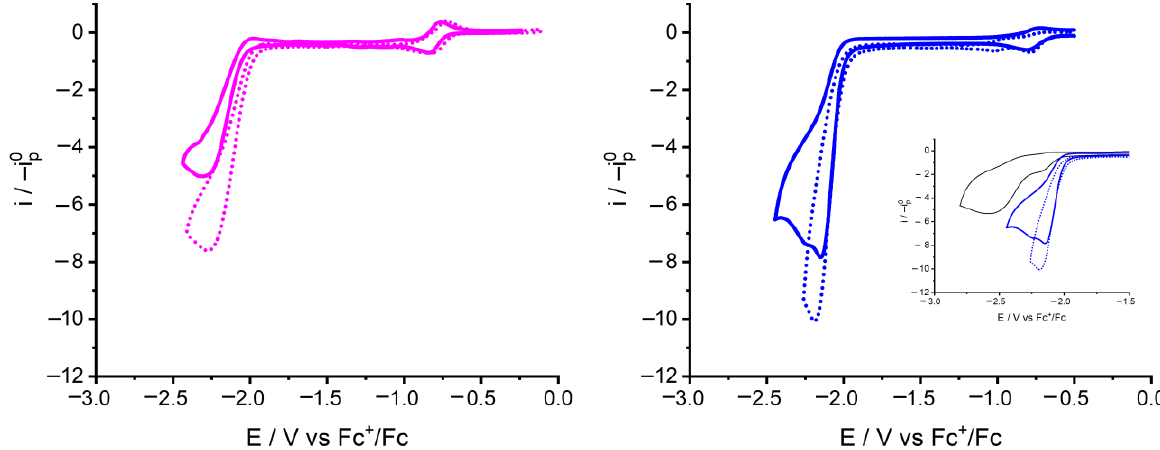
Figure 5. Cyclic voltammetries of 1 mM Fe(salen)Cl ( left ) and Fe(beacen)Cl ( right ) in acetonitrile (0.1 M Et 4 NBF 4 electrolyte), under CO 2 atmosphere, in the presence of 0.3 M trifluoroethanol (TFE, solid traces) or 0.5 M phenol (PhOH, dotted traces) as proton donors. The current of the voltammetries is normalized with respect to the peak current of the Fe II → Fe I reduction wave under dinitrogen in the absence of proton donors, in order to allow a direct comparison with Figure 2. The same experimental conditions as those reported in the caption of Figure 2. The inset on the right in Figure 5 shows the comparison of the voltametric traces with Fe(beacen)Cl in the presence of proton donors (blue traces) with the one registered in the absence of proton donors (black trace, see also Figure 2), that allows one to appreciate the current enhancement of the first catalytic process in the presence of proton donors; see previous discussion. In the presence of the proton donors, variation of the E 1/2 of the Fe III/II couple and cathodic Fe III → Fe II wave splitting are observed, see Figures S12 and S13 and Table S1. These observations are coherent with protonation equilibria of the complex, presumably at the ligand phenoxide and/or enolate oxygen sites, along with PhOH or TFE coordination to Fe III with competition with the Cl – ligand for apical coordination see refs [11,12]. Table 2. Electrochemical reduction of CO 2 with iron complexes in the presence of phenol (PhOH) or trifluoroethanol (TFE) proton donors.